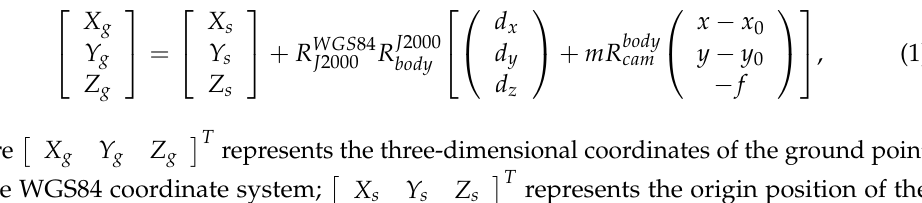
satellite body-fixed coordinate system in the WGS84 coordinate system; R WGS 84 transformation matrix from the J2000 coordinate system to the WGS84 coordinate